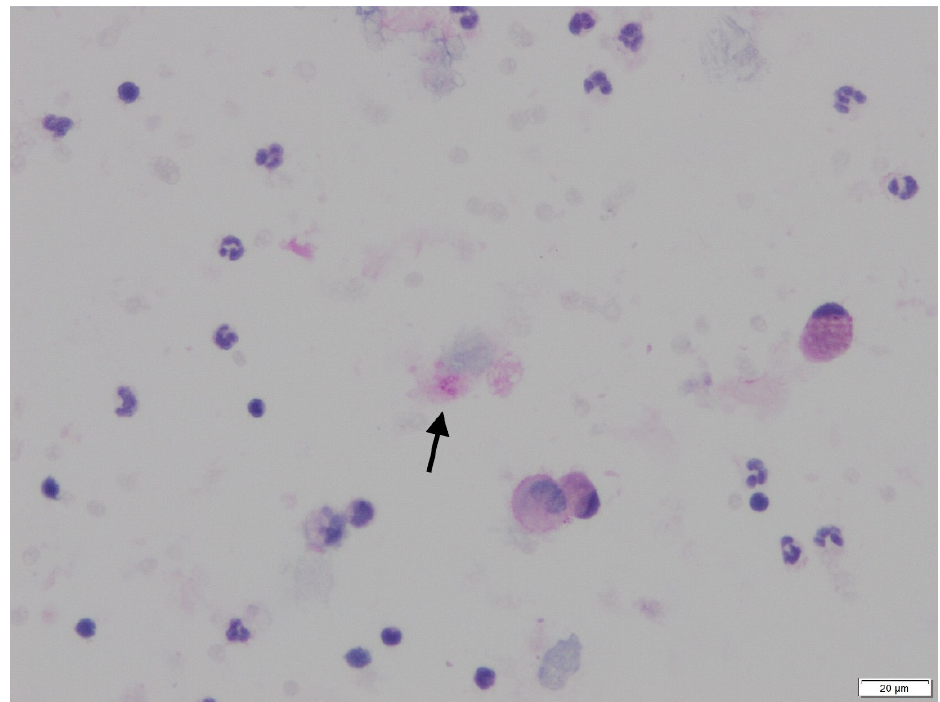
Figure 1. PAS (Periodic Acid Schiff) staining highlights the round cysts with a small central condensa- tion (arrow) corresponding to the organisms of Pneumocystis , isolated on BAL cytology of patient 3.